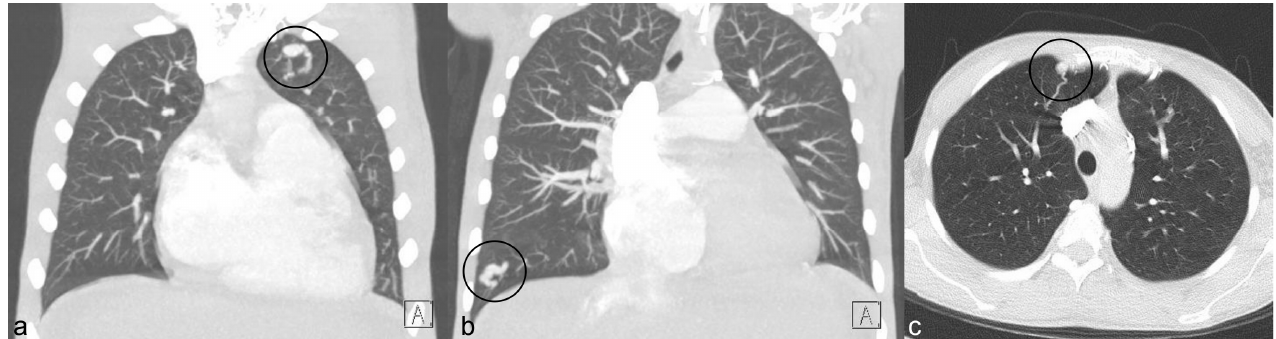
Figure 2. Contrast - enhanced chest CT. Coronal MIP ( a ,b) and axial ( c ) images show peripheral AVMs, seen as non-calcified nodules with a feeding arterial vessel (within black circle in b). MIP: Maximum Intensity Projection .